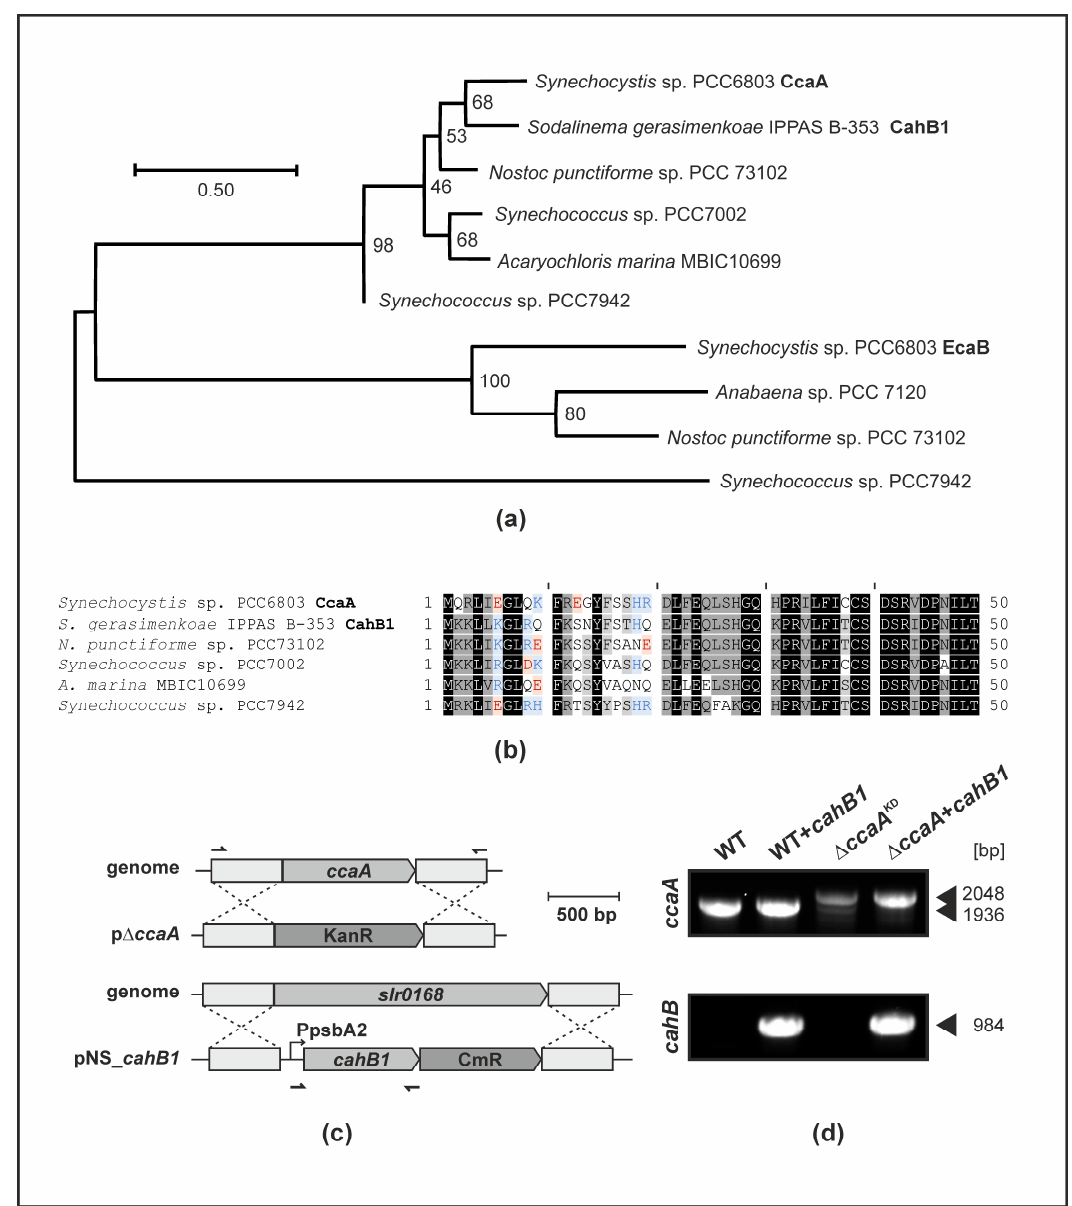
Figure 1. Sodalinema gerasimenkoae CahB1 is highly homologous to Synechocystis CcaA. ( a ) Maximum likelihood (log likelihood −2438.93) phylogenetic tree reconstruction of β-CA from different repre- sentative model cyanobacteria. Numbers next to nodes indicate bootstrap support over 200 repli- cates. The branch lengths are proportional to the number of substitutions per site (see scale bar). The analysis involved 10 amino acid sequences with a total of 174 homologous positions in the final dataset. ( b ) N-terminal protein sequence alignment of CcaA/CahB1 homologues included in ( a ). Conserved positions (black), highly similar positions (>80% similarity/identity; dark grey), and sim- ilar positions (>60% similarity/identity; light grey) are highlighted. Non-conserved charged amino acid residues in the first 20 positions are highlighted in blue (basic) and red (acidic). ( c ) Schematic maps of the pΔ ccaA knock-out and the pNS_ cahB1 knock-in constructs used in this study. KanR, kanamycin resistance gene nptI ; CmR, chloramphenicol resistance gene cat ; PpsbA2, promoter of Synechocystis psbA2 gene encoding D1 subunit of photosystem II; bp, base pairs. Upstream/down- stream regions used for homologous recombination with genomic target loci ccaA ( slr1347 ) and neu- tral site ( slr0168 ) are indicated as grey boxes. Primer-binding sites for genotyping PCR are indicated as half arrows. ( d ) Genotyping PCR of Synechocystis wildtype ( WT ), wildtype transformed with a CahB1 expression construct (WT + cahB1 ), mutant harbouring the ccaA deletion construct (Δ ccaA KD ), and mutant harbouring the ccaA deletion construct transformed with cahB1 expression construct (Δ ccaA + cahB1 ). Positions and sizes of the WT ccaA locus amplicon (1936 bp), the Δ ccaA locus am- plicon (2048 bp), and the cahB1 expression construct amplicon (984 bp; PpsbA2: cahB1 ) are high- lighted with arrowheads. Note the change from incomplete to complete segregation status of Δ ccaA upon introduction of the cahB1 gene.